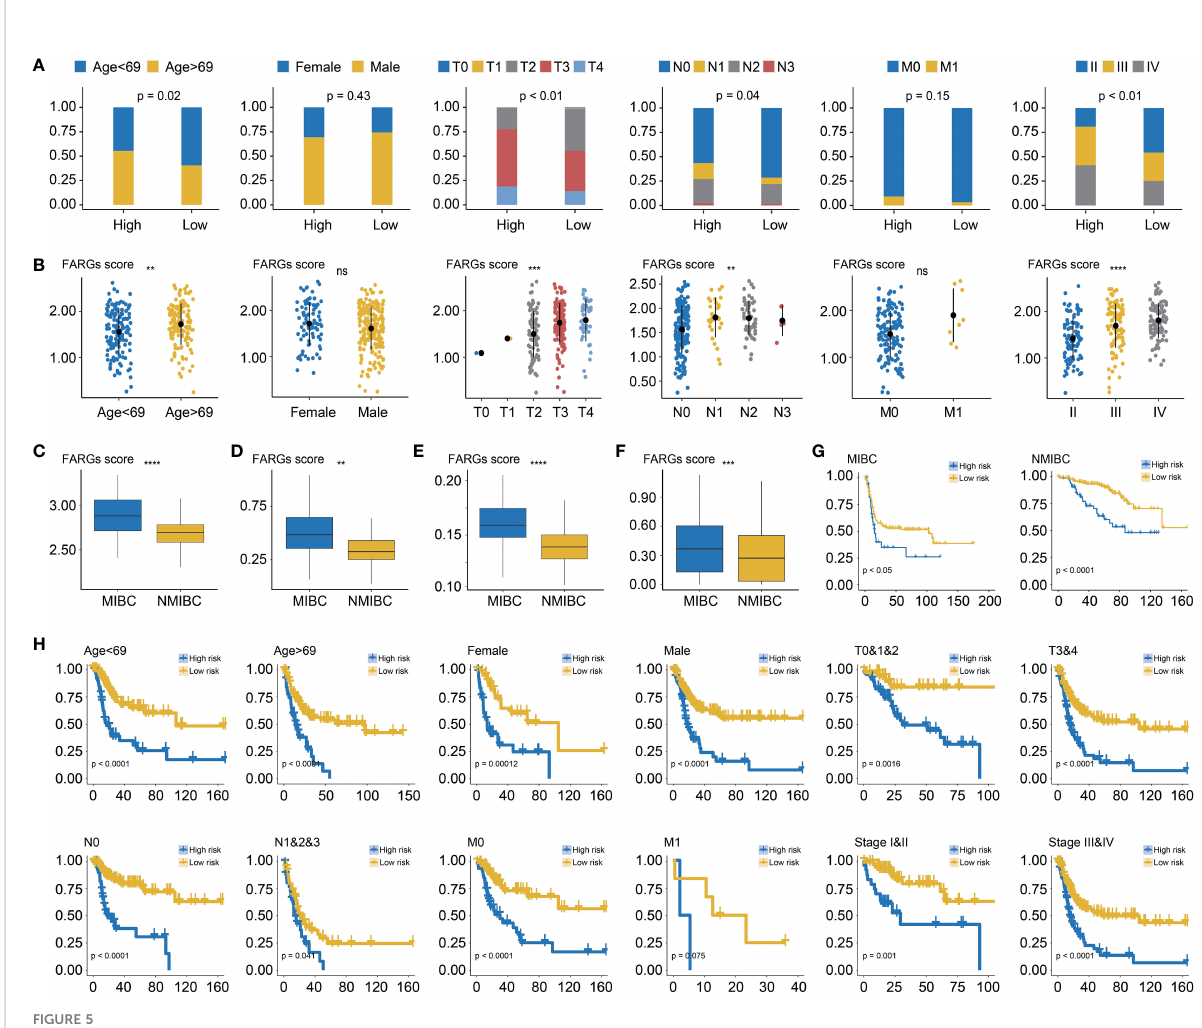
FIGURE 5 The correlation analysis between the FARG signature and clinical features. (A) The clinical association analysis demonstrated that more advanced BC patients were enriched in the high-risk group. (B) The FARG signature score was positively correlated with advanced clinical status. (C) Muscle-invasive BC (MIBC) patients had higher FARG scores than NMIBC patients in GSE13507. (D) MIBC patients had higher FARG scores than NMIBC patients in GSE31684. (E) MIBC patients had higher FARG scores than NMIBC patients in GSE32548. (F) The comparison analysis of FARG score between MIBC and NMIBC groups by integrating MIBC or NMBIC patients from GSE13507, GSE31684, and GSE32548. (G) Kaplan – Meier curve analysis, in the cohort of merging GSE13507, GSE31684, and GSE32548 datasets, for high- and low-risk groups among MIBC patients or NMIBC patients. (H) The strati fi cation analysis revealed the robust ability of the FARG signature in prognosis prediction, which also exhibited the potential to predict OS for early-stage BC patients. ** indicated p < 0.01, *** indicated p < 0.001, **** indicated p < 0.0001, ns indicated no statistically signi fi cant